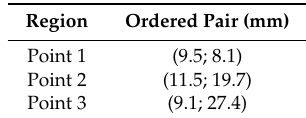
Table 2. Coordinates of the sample measurement